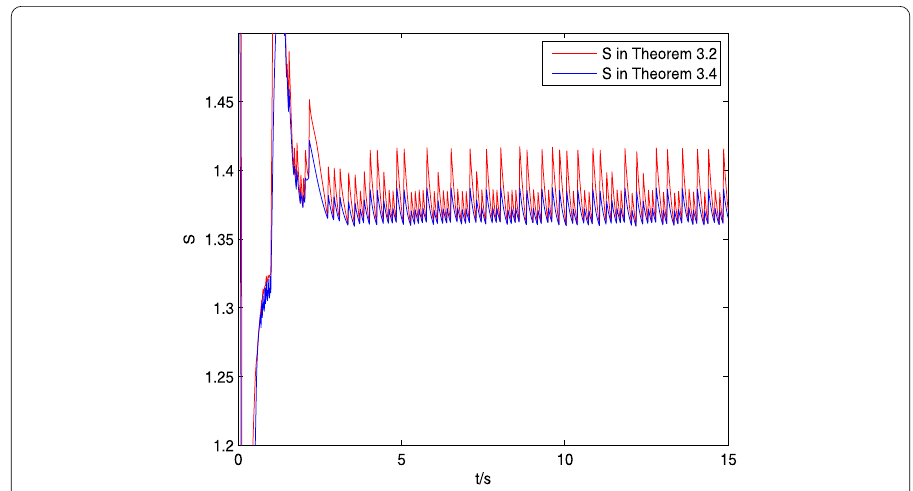
Figure 3 The positive invariant sets in Theorem 3.2 and Theorem 3.4 of Example 1